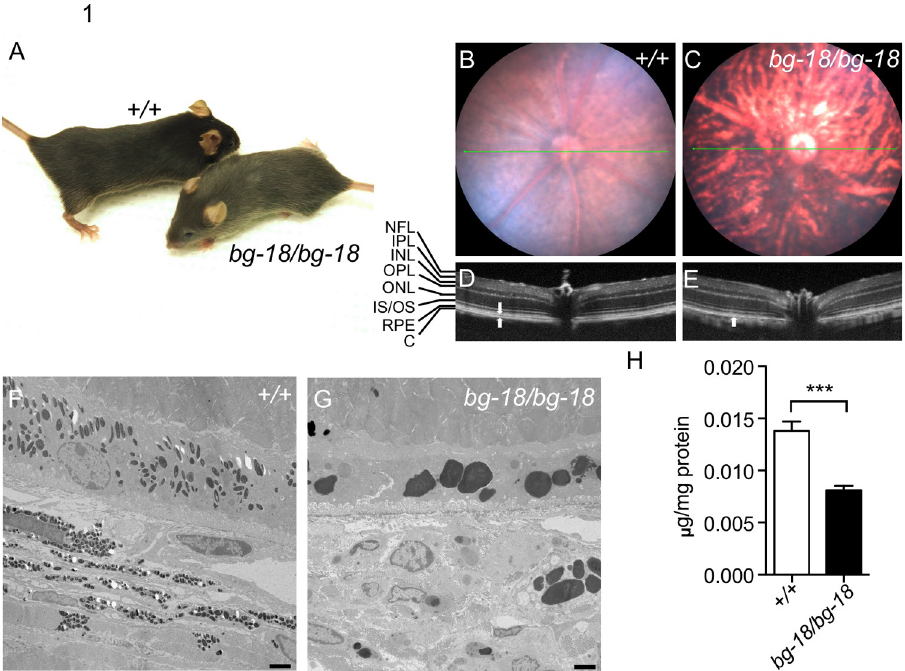
Fig 1. The clinical and pathological effects of the bg-18 mutation on mouse retina. (A) 5-week-old wild type (+/+) and bg-18/bg-18 mutant littermates on the C57BL/6J background. Note the lighter coat color of the bg-18 mutant. (B-E) Abnormalities of pigmentation and reflective properties in the bg-18 mutant retina. Fundus (B, C) and OCT (D, E) images of wild type (B, D) and bg-18 mutant (C, E) retinas from 4-month-old mice. Retinal layers are labeled to the left. NFL: Neurofilament layer; IPL: Inner plexiform layer; INL: Inner nuclear layer; OPL: Outer plexiform layer; ONL: Outer nuclear layer; IS/OS: Inner segment/outer segment; RPE: Retina pigment epithelium; C: Choroid. Note that there are two hyper-reflective layers in the wild type retina at the location of RPE and choroid (arrows), whereas only one layer is detected in the mutant retina (arrow). (F-G) Electron micrographs of retinas from the 11-week-old wild type (F) and bg-18 mutant (G) retinas. Scale bar = 2 μ m. Three mice of each genotype were examined. (H) Melanin level is reduced in the bg-18 mutant retina from 5-week-old mice. ��� : p < 0.001, mean ± SD, n = 3 per cohort.